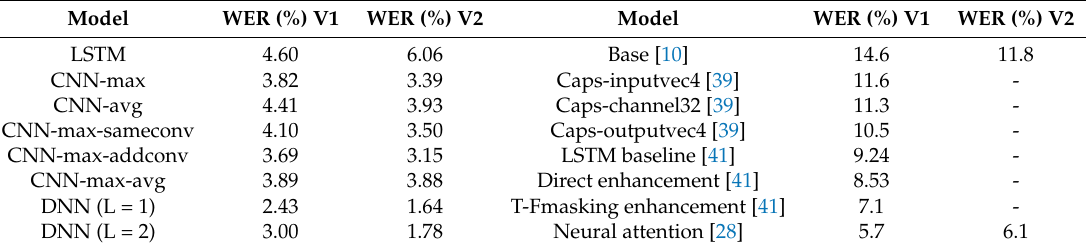
Table 5. WER of deep models trained and tested on clean